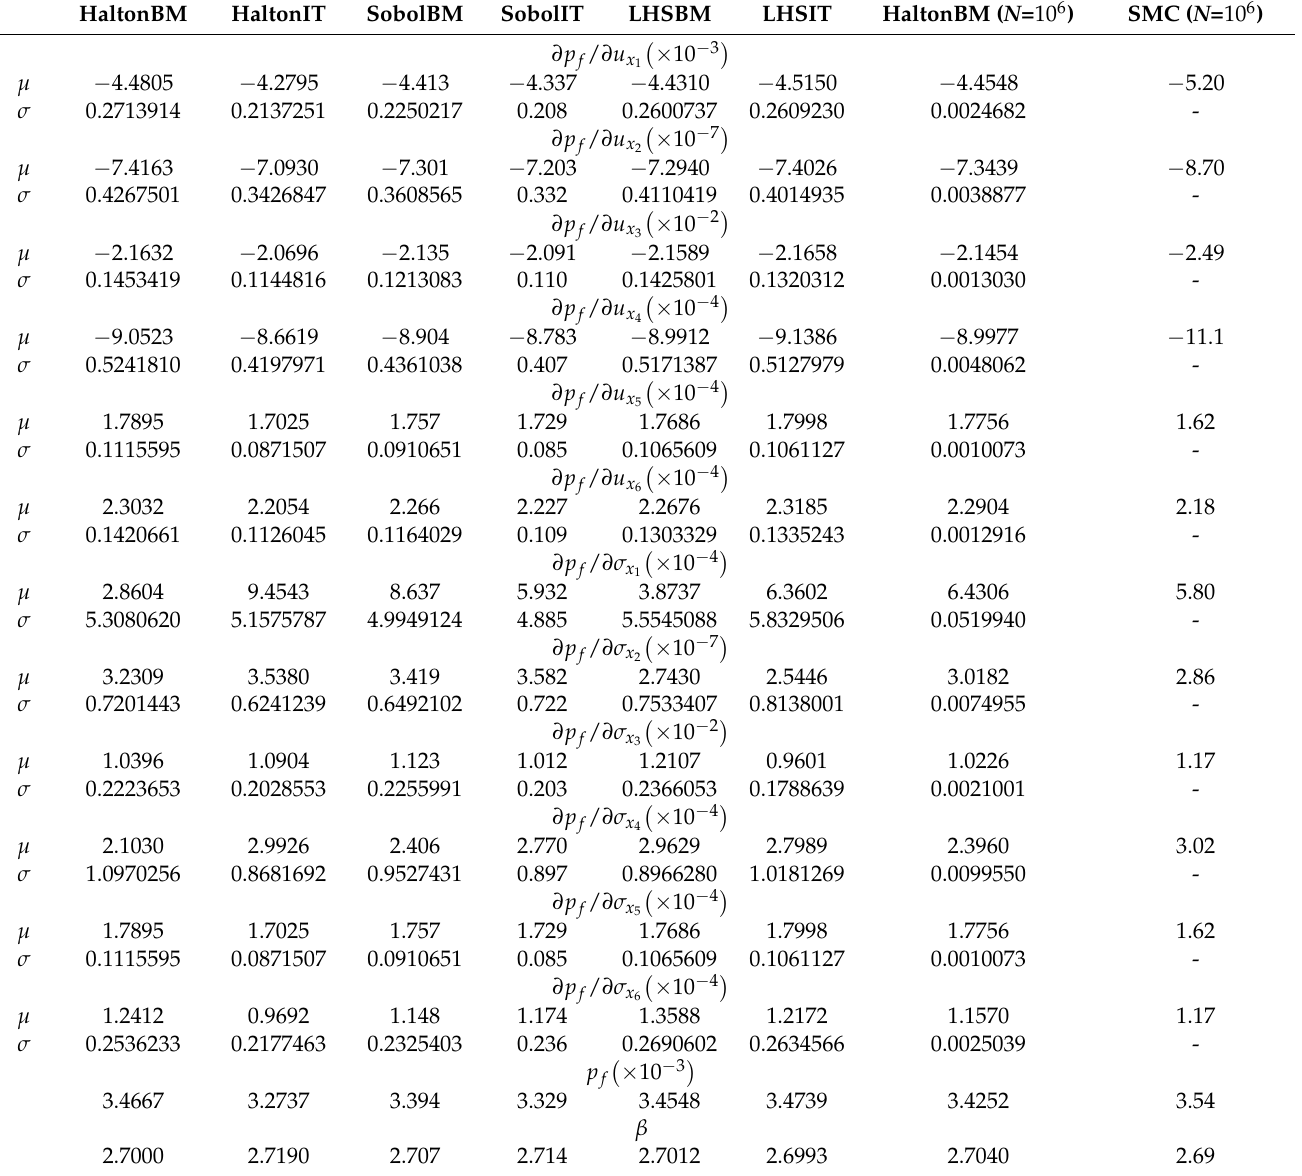
Table 4. Reliability and sensitivity results of different methods in Example 2 when N =